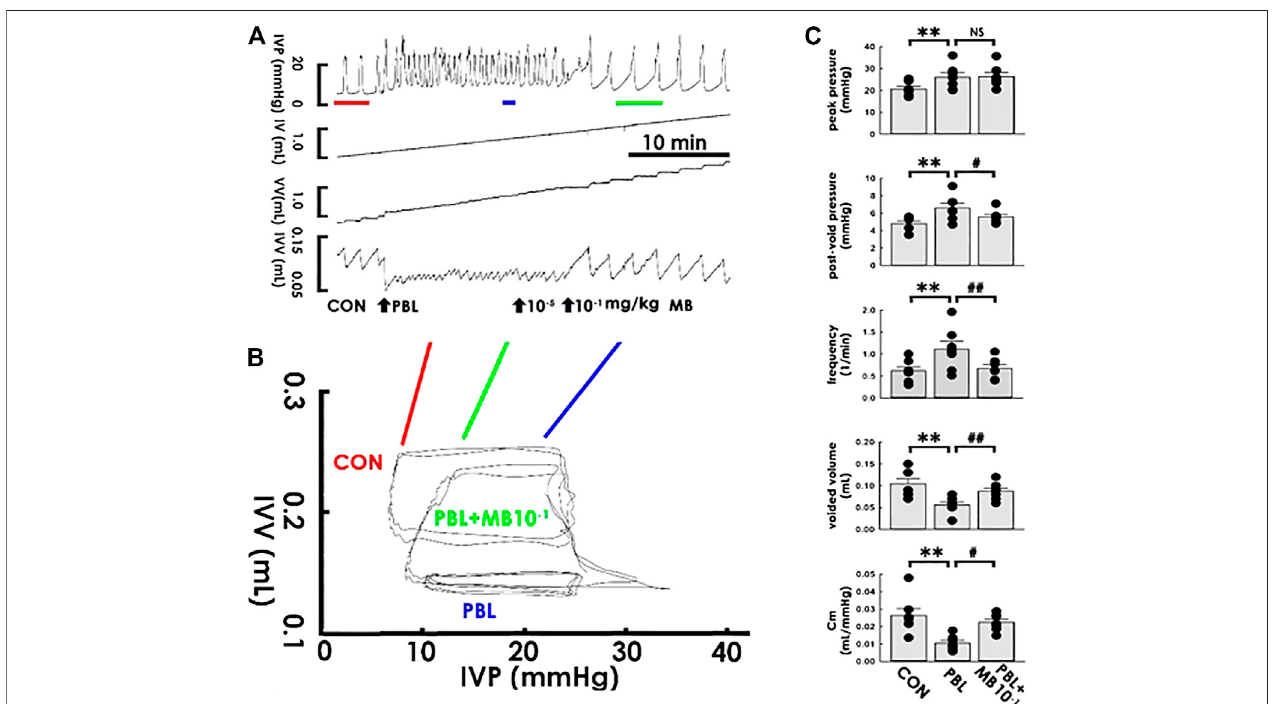
FIGURE 6 | Mirabegron ameliorates bladder ligation-reduced compliance. (A) Cystometry before (control; CON) and in response to a partial bladder ligation (PBL) followed by intra-arterial injections of mirabegron (MB; 10 − 5 and 10 − 1 mg/kg). Red, blue, and green bars at the bottom of IVP mark the cycles displayed in the pressure- volume analysis. (B) Pressure-volume loops showing a partial bladder ligation reduces the slope of the regression line of the fi lling phase that is marked reversed by mirabegron with a concentration of 10 -1 mg/kg (MB + SF10 − 1 ). (C) A partial bladder ligation statistically increases the peak pressure, post-void pressure, voiding frequency but decreases voided volume and mean compliance (Cm; ** p < 0.01, vs. CON; all n (cid:2) 7) that are all ameliorated by mirabegron (10 − 1 mg/kg) excepting the peak pressure ( # p < 0.05, ## p < 0.01 vs. PBL; all n (cid:2)